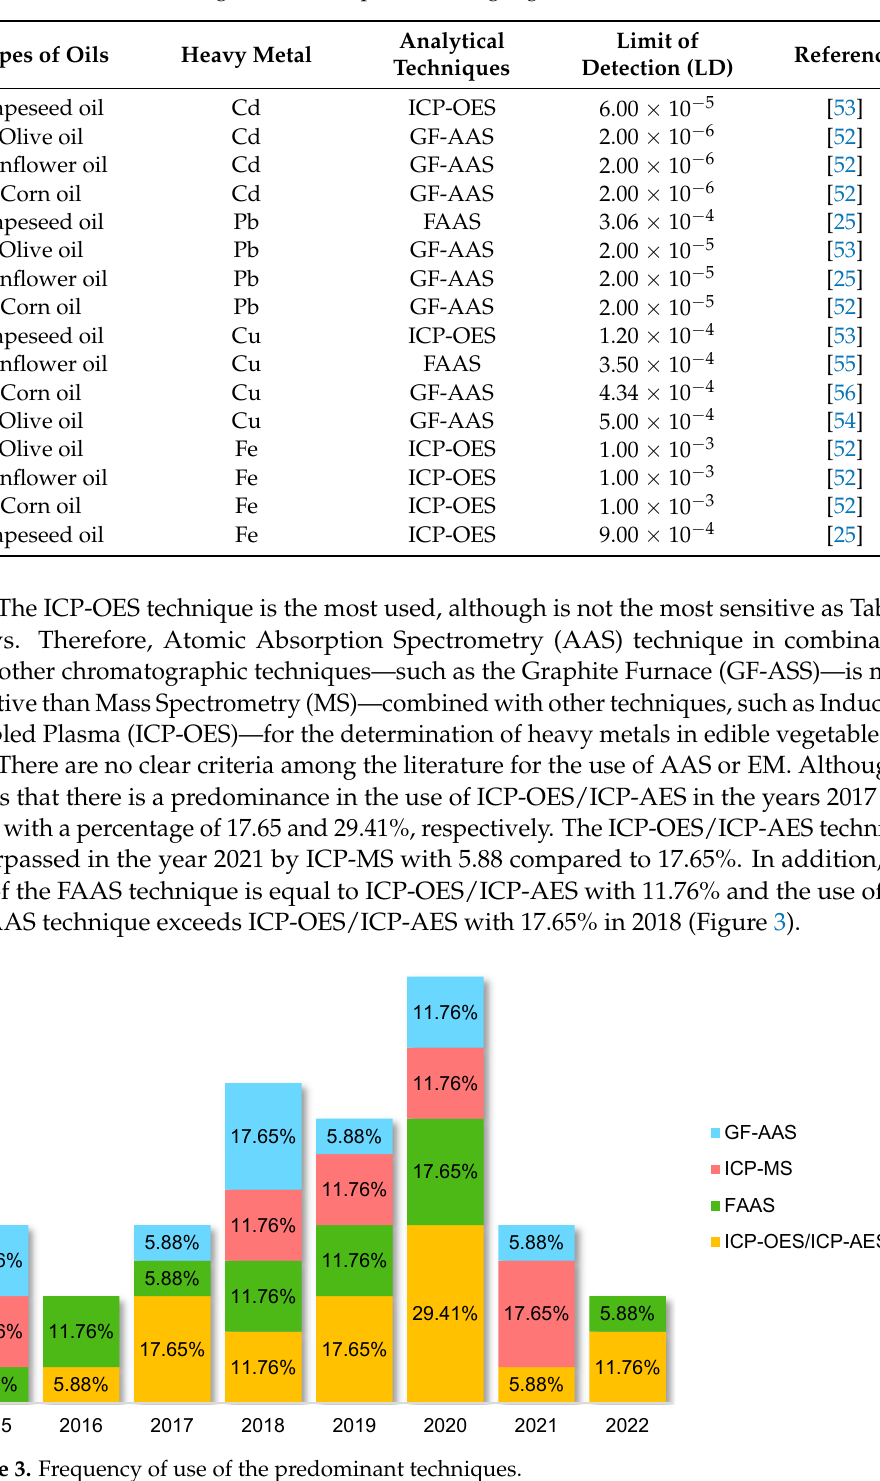
Figure 3. Frequency of use of the predominant techniques.